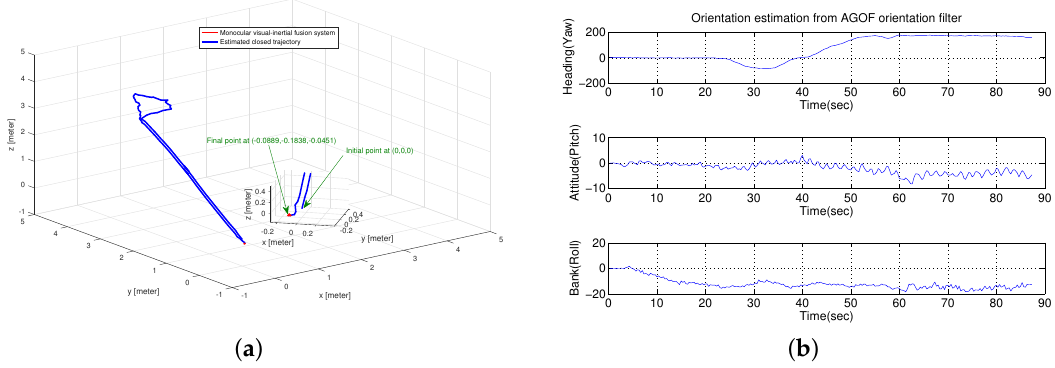
Figure 13. Closed-loop Motion Estimation. ( a ) closed trajectory estimation; ( b ) orientation estimation from AGOF filter.